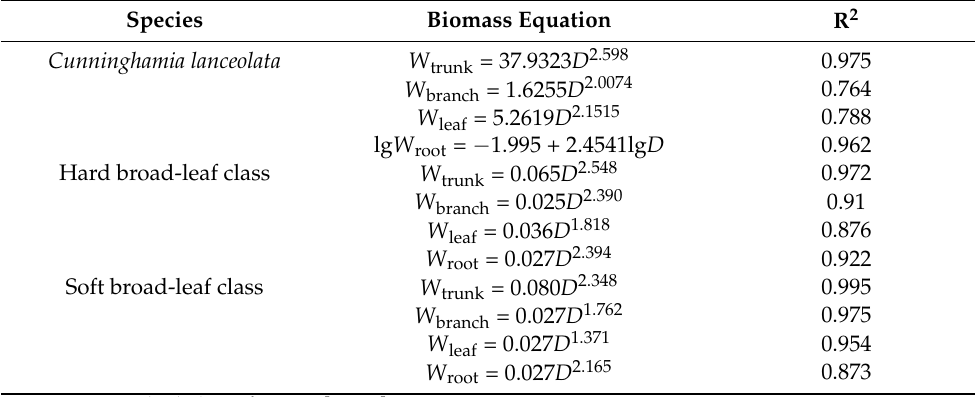
Table 3. Biomass allometric growth equation of different tree species in the tree